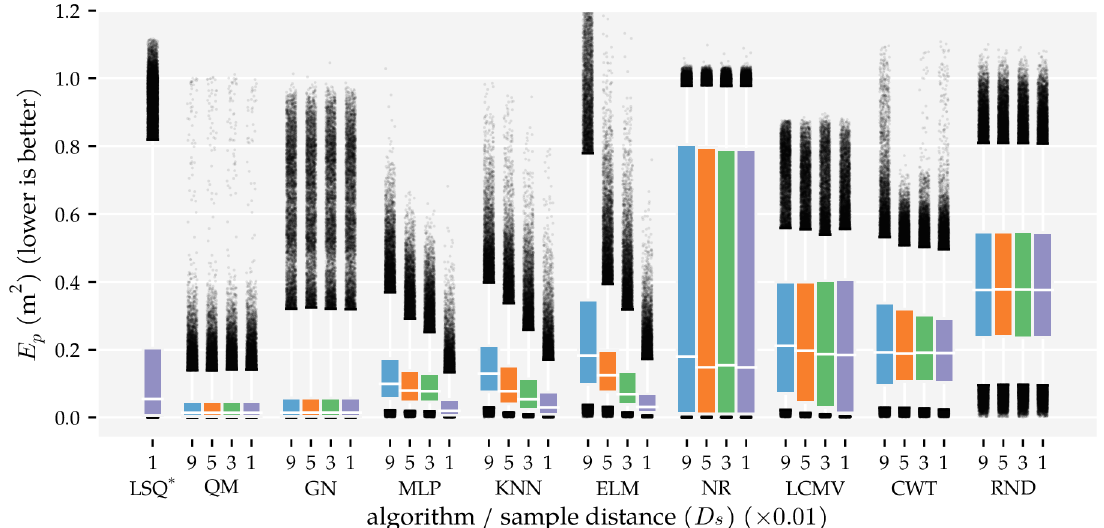
Figure 7. Boxplots of the position error distributions for all dipole localisation algorithms in each condition of first analysis method. This analysis varied the minimum distance D s between source states in the training and optimisation set (see Section 2.3 and Table 1) and used the (x + y) sensor configuration at the σ = 1.0 × 10 − 5 ms − 1 noise level. The whiskers of the boxplots indicate the 5th and 95th percentiles of the distributions. Predictions with errors outside these percentiles are shown individually. LSQ* is based on the (x + y) condition in Analysis Method